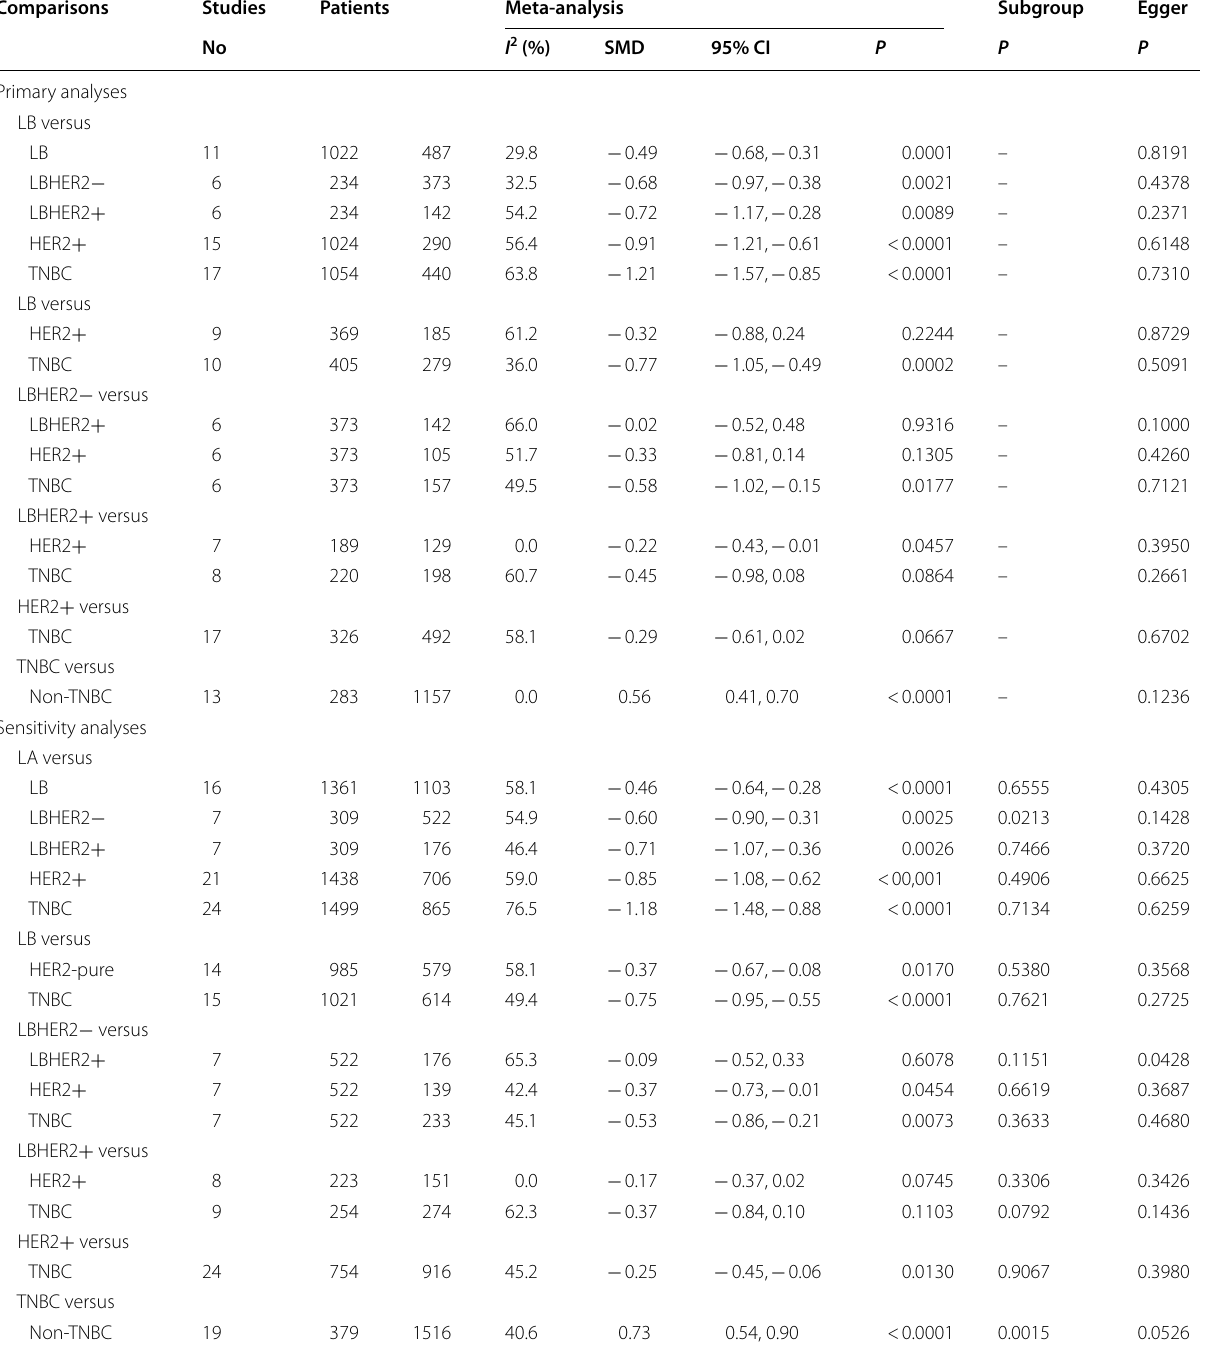
Table 2 Estimates of the SMD as summary measure for the difference in [18F]FDG (SUV intrisic